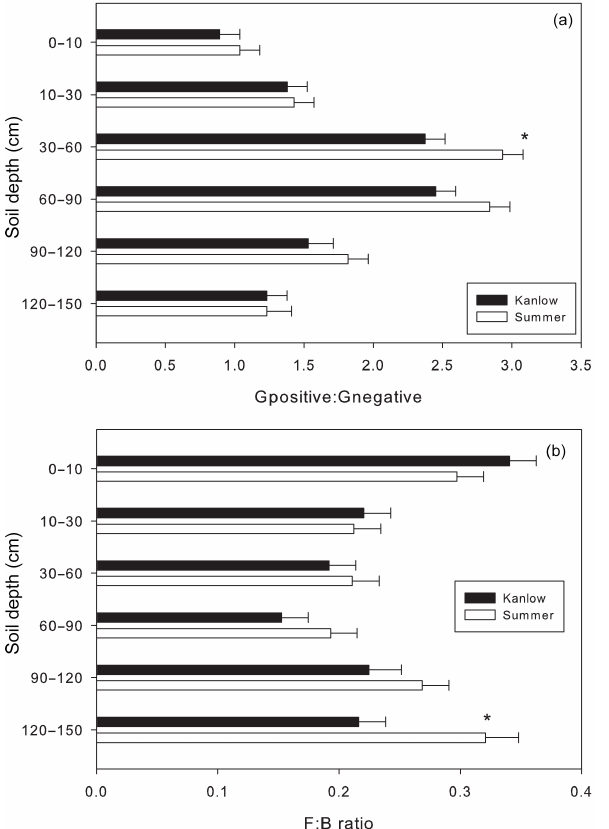
Figure 3. Gram-positive:Gram-negative ratios (a) and fun- gal:bacterial ratios (b) for switchgrass ecotypes Kanlow and Sum- mer by depth. The asterisk indicates a significant difference be- tween ecotypes within